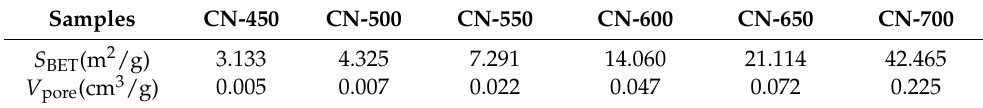
Table 3. S BET and V pore of